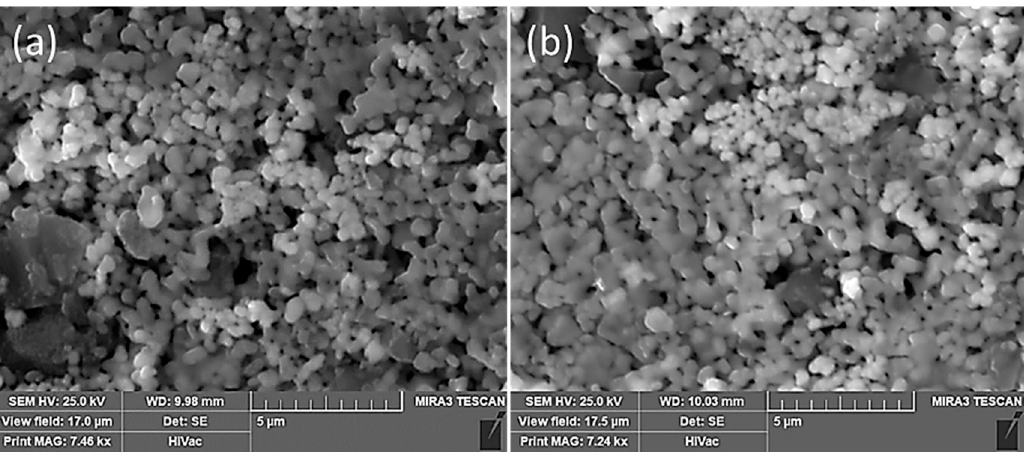
Figure 3. Scanning electron microscope images of sintered pellets: ( a ) 900 °C; ( b ) 950 °C.